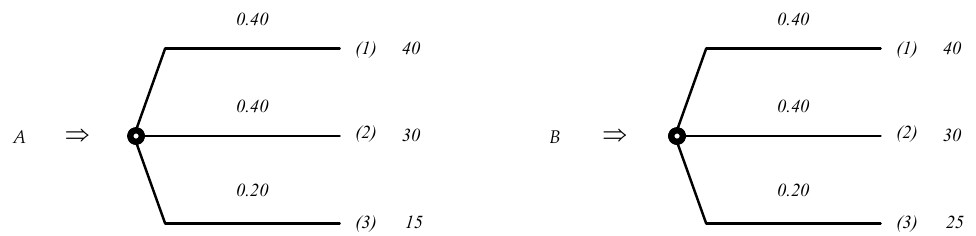
Figure 1. Graphical representation of two prospects.